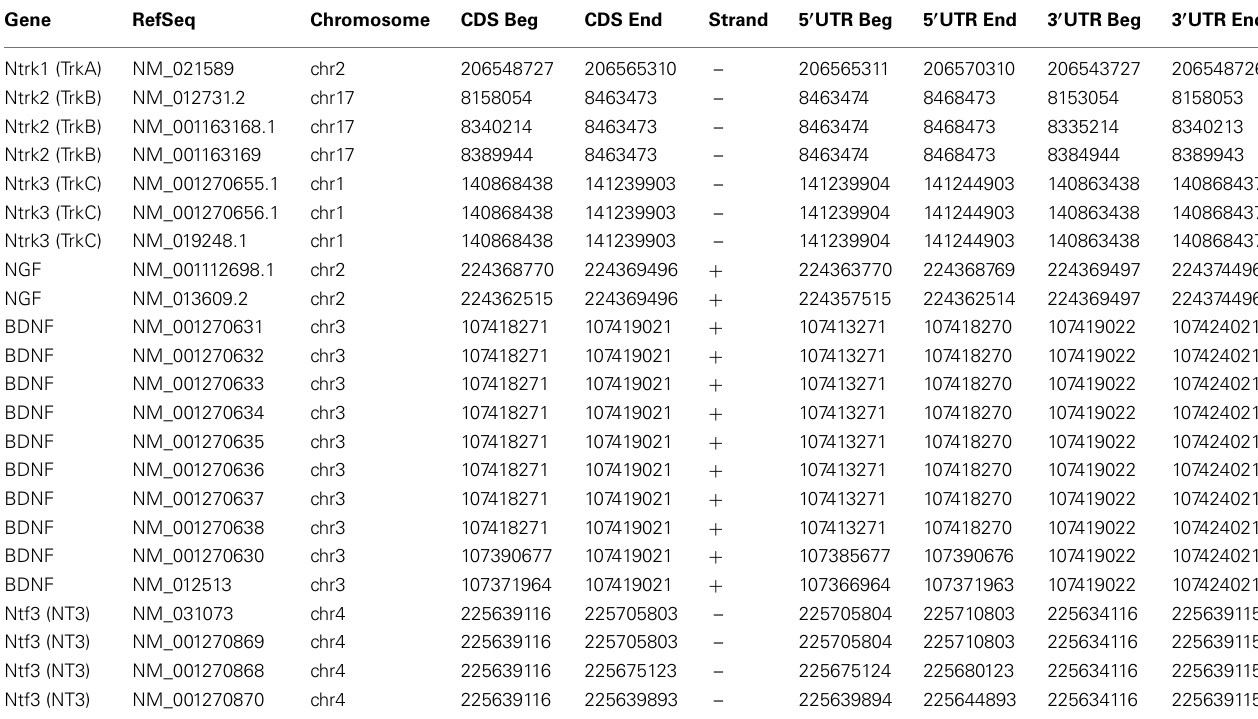
Table 5 | Genomic coordinates used for Bioinformatic